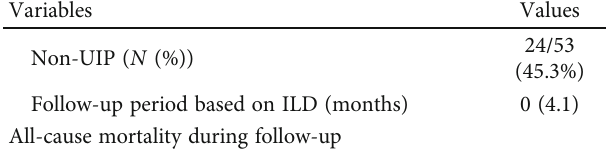
Table 1: Baseline characteristics of patients with AAV at diagnosis ( N = 255